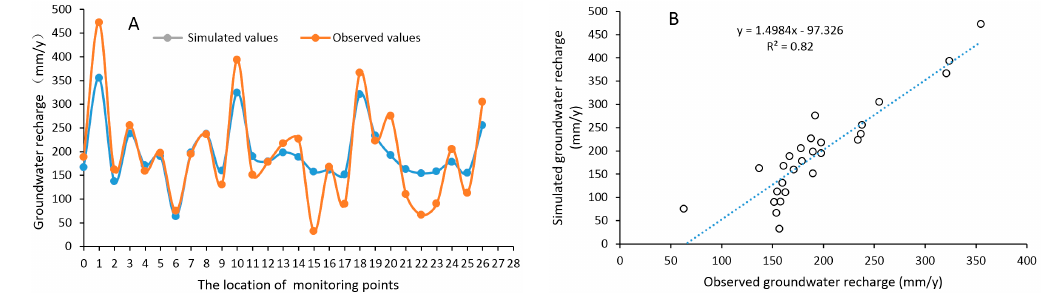
Figure 4. Evaluation of simulated and measured groundwater recharge: ( A ) the simulated values and observed values of groundwater recharge in 2012 for 27 monitoring points; and ( B ) the linear relationship between simulated and observed groundwater recharge.